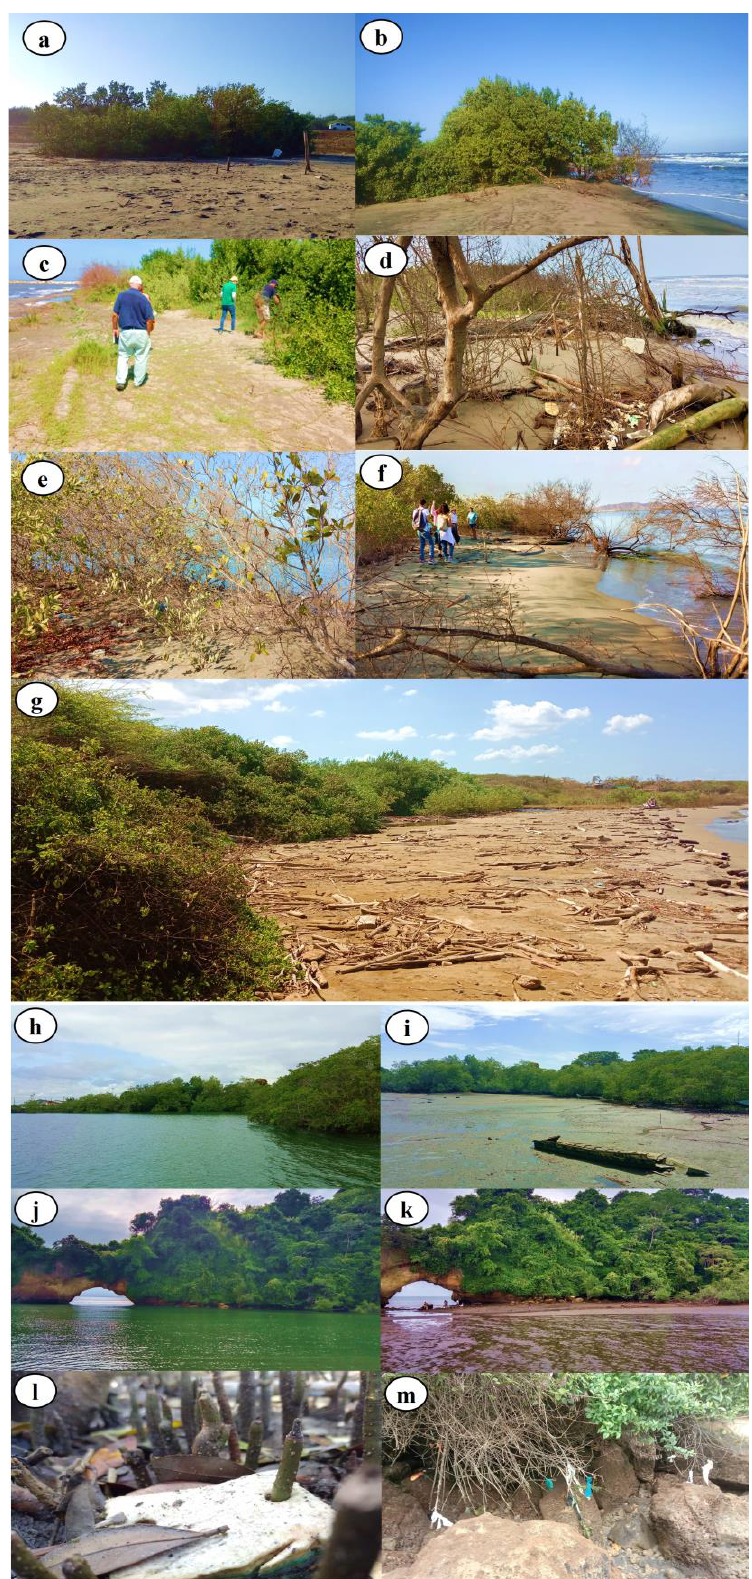
Figure 2. Images of the beaches/mangrove forests studied: ( a ) Salamanca A; ( b ) Salamanca B; ( c ) Puerto Colombia; ( d ) Balboa; ( e ) Puerto Caimán A; ( f ) Puerto Caimán B; ( g ) Aguamarina; ( h ) Complejo DIMAR (at high tide); ( i ) Complejo DIMAR (at low tide); ( j ) El Morro (at high tide); ( k ) El Morro (at low tide); ( l ) Litter trapped in a pneumatophore at Salamanca A; ( m ) The “Christmas tree” effect due to litter trapped in a plant of Rhizophora sp. at El Morro.